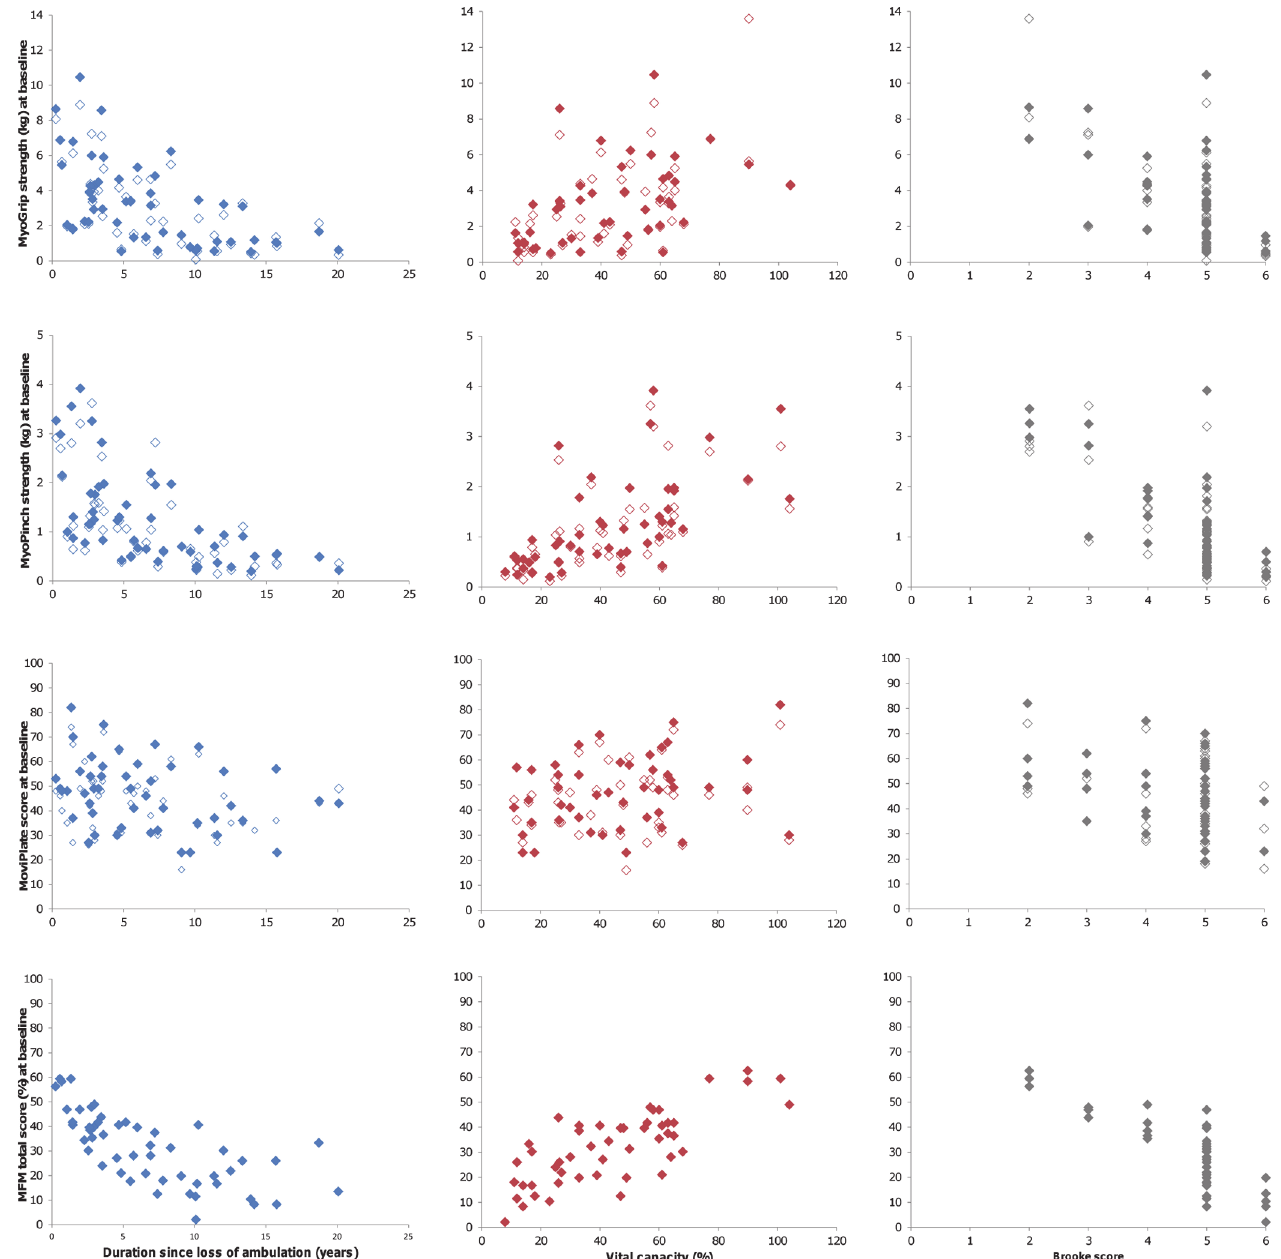
Figure 2. Correlation between MyoSet values at baseline and clinical